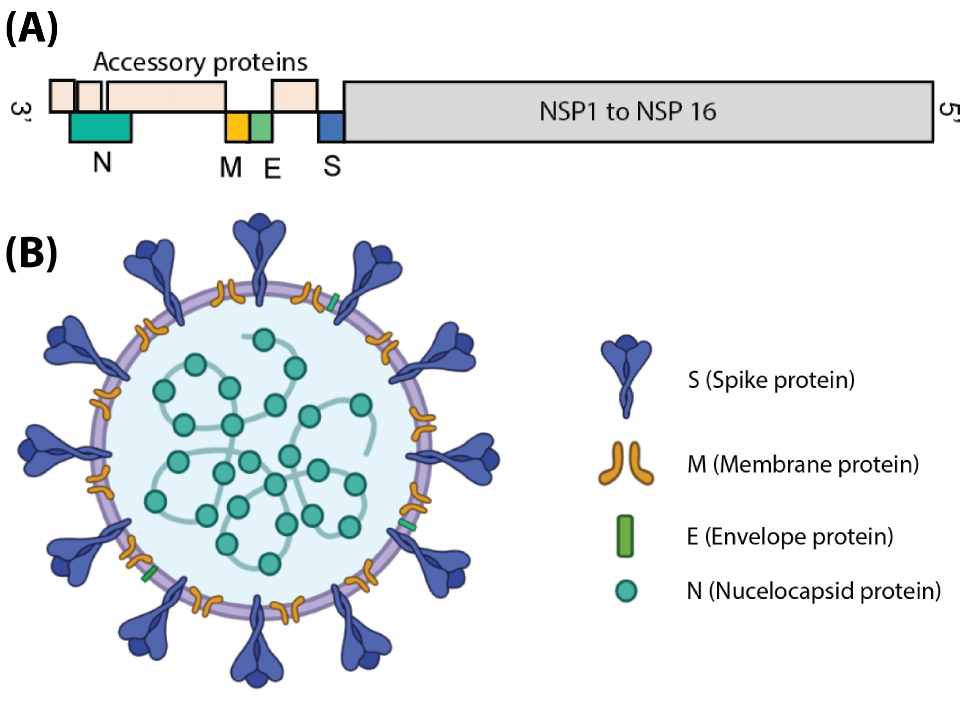
Figure 2. ( A ) The arrangement of the SARS-CoV-2 genome and position of proteins in it. ( B ) The organization of the major structural proteins in the virus